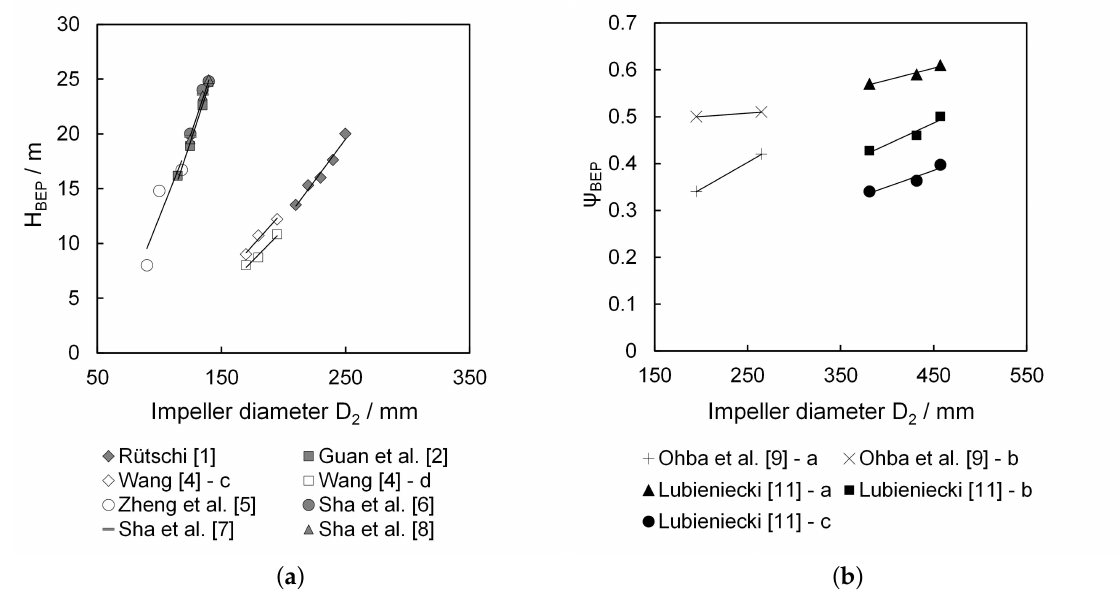
Figure 10. ( a ) Head over impeller diameter; and ( b ) pressure coefficient over impeller diameter.